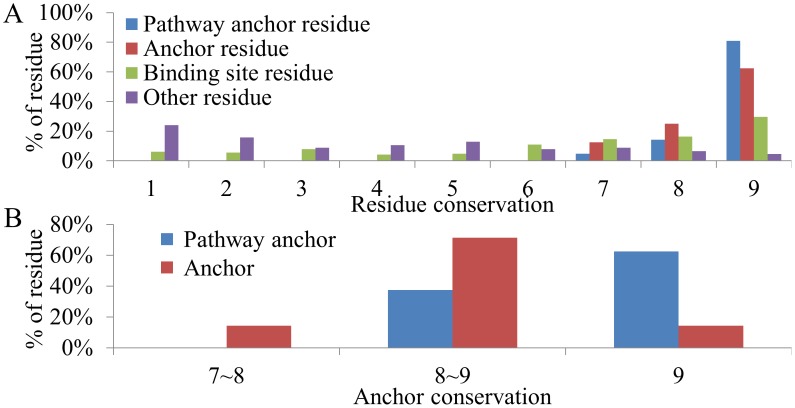
Comparison of conservation scores.(A) Conservation-score distribution of pathway anchor residues, anchor residues, binding site residues, and other residues. The scores are from 1 (least conserved) to 9 (most conserved). (B) Conservation-score distribution of pathway anchors and anchors. A conservation score of a pathway anchor or an anchor is derived by averaging the conservation scores of pathway anchor residues or anchor residues.